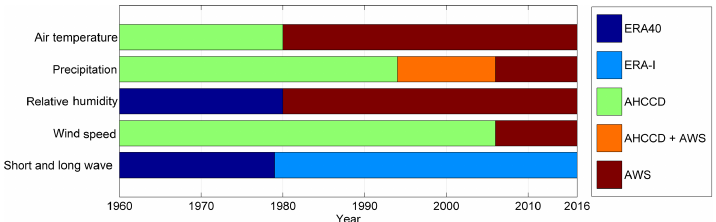
Figure 2. Data source for each of the weather variables during the period 1960–2016. AWS: automatic weather station. AHCCD: Adjusted and Homogenized Canadian Climate Data. ERA-I: